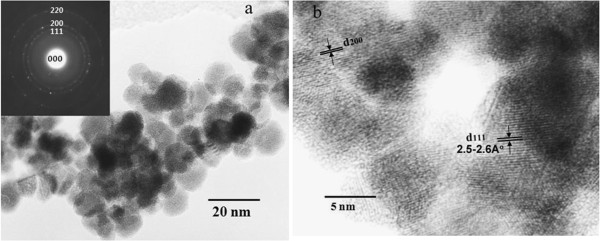
TEM micrograph (a), SAED pattern (inset of a), and HRTEM image (b) of cubic TaN nanoparticles.